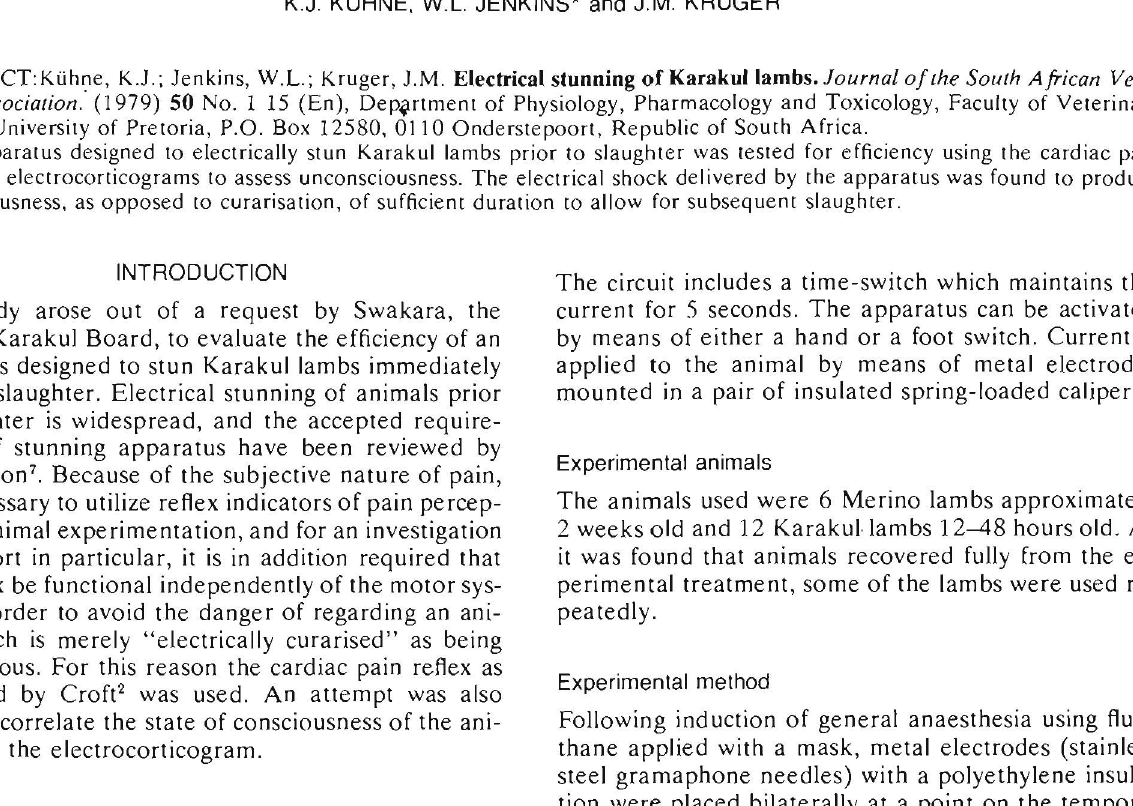
Fig. 1. The apparatus assembled for use, showing the power unit (A) connected to the battery, the electrodes (B) and foot switch (c).